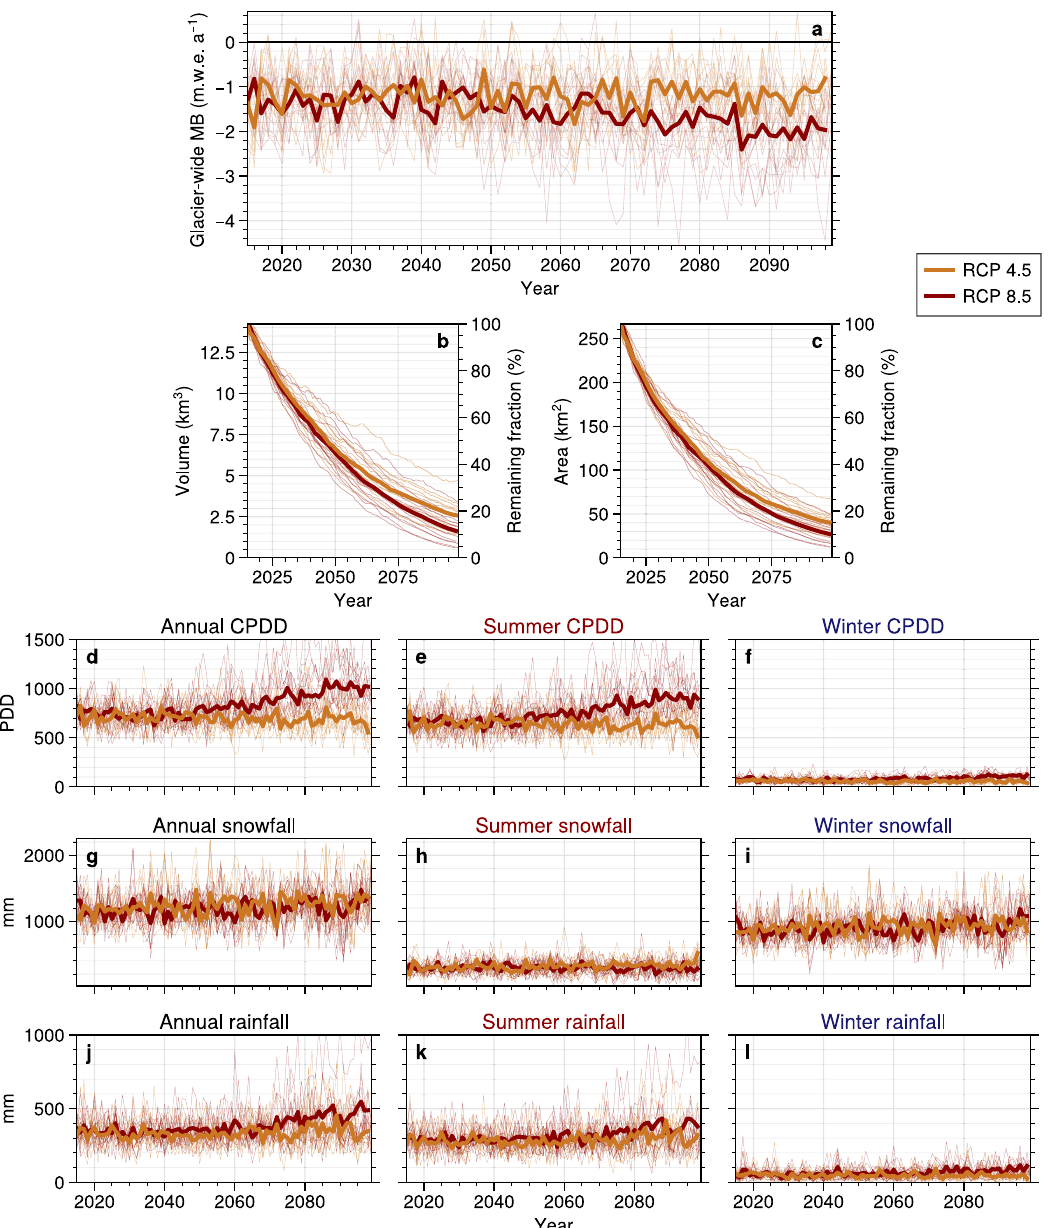
Fig. 1 21st century glacier-wide MB, geometry and climate signal evolution of French Alpine glaciers. a Glacier-wide annual MB, b Ice volume, c Glacier area. The cumulative positive degree days (CPDD), snowfall and rainfall d – l , are at the glaciers ’ annually evolving centroids. As such, these values re fl ect both the climatic forcing and the changing glacier geometry. Summer climate is computed between April 1 st and September 30 th and winter climate between October 1st and March 31st. Thin lines represent each of the 29 individual member runs, while the thick lines represent the average for a given (Ecrins region) massifs under RCP 4.5 (Fig. 2) and RCP 8.5 by the end of the century. By 2100, under RCP 4.5, these two high-altitude massifs are predicted to retain on average 26% and 13% of their 2015 volume, respectively, with most of the ice concentrated in a few larger glaciers (>1 km 2 , Fig. S4). Glacier landscapes are expected to see important changes throughout the French Alps, with the average glacier altitude becoming 300 m (RCP 4.5) and 400 m (RCP 8.5) higher than nowadays (Fig. 2a and S3).